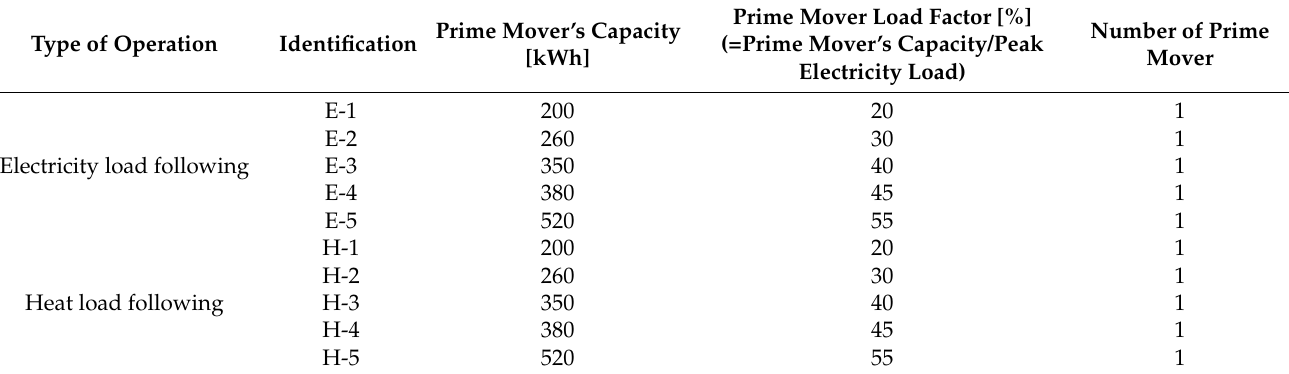
Table 3. System and operating conditions for the scenarios of the diagnostic analysis.